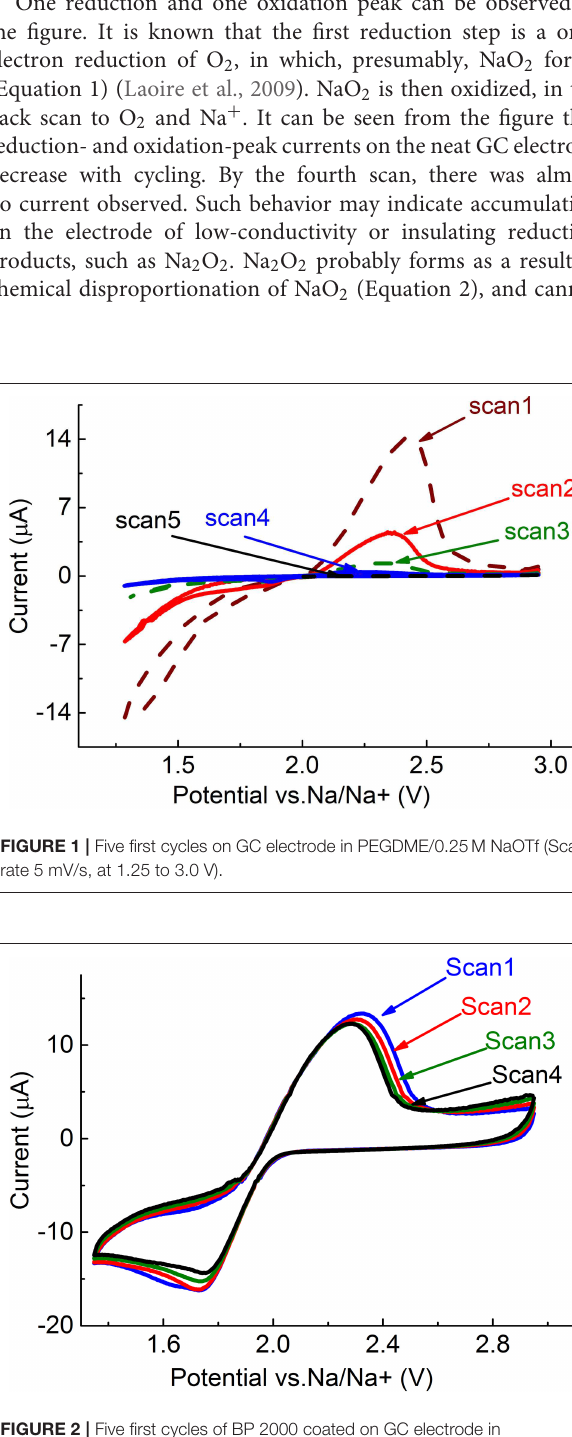
Frontiers in Materials |